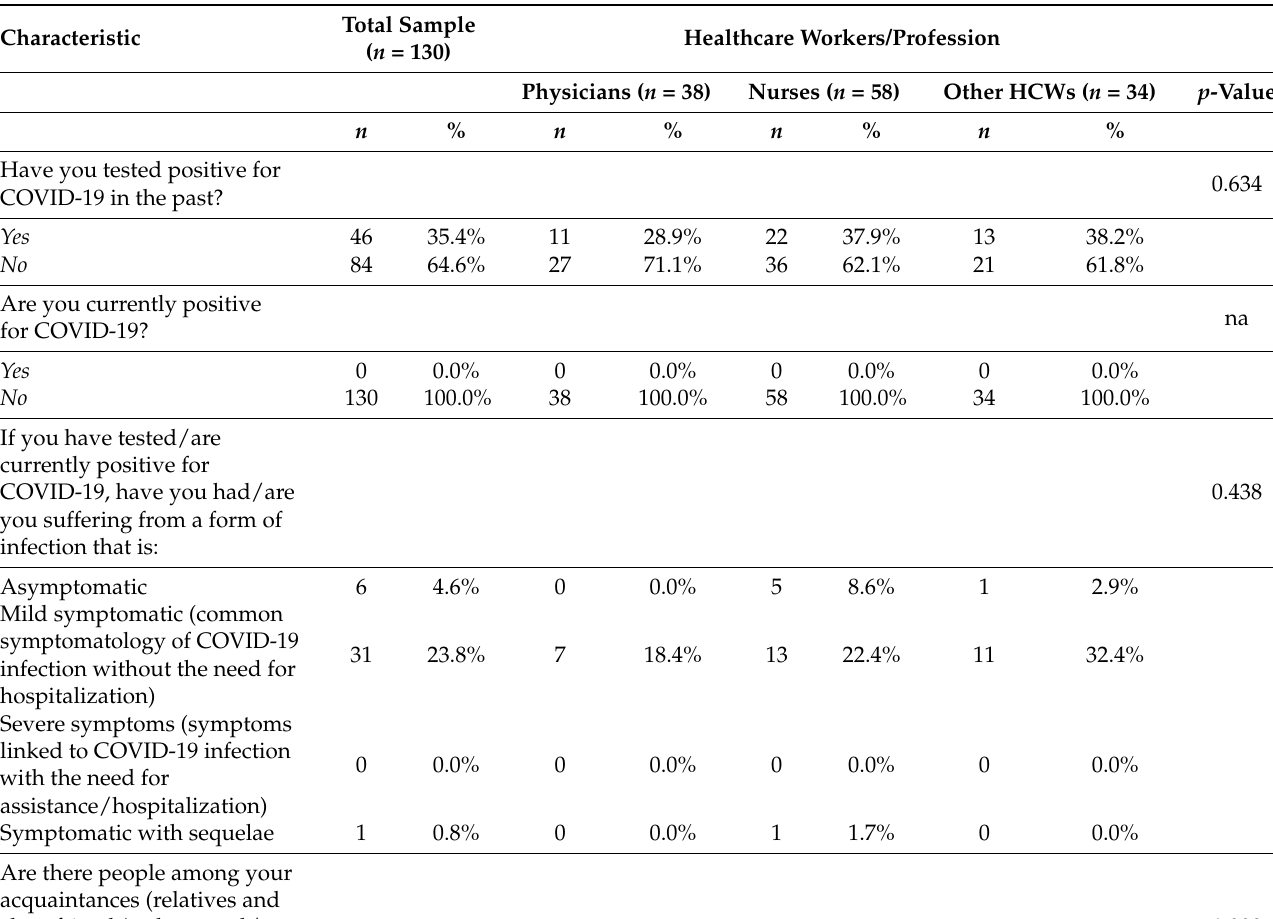
Table 2. Personal experiences of healthcare workers with COVID-19